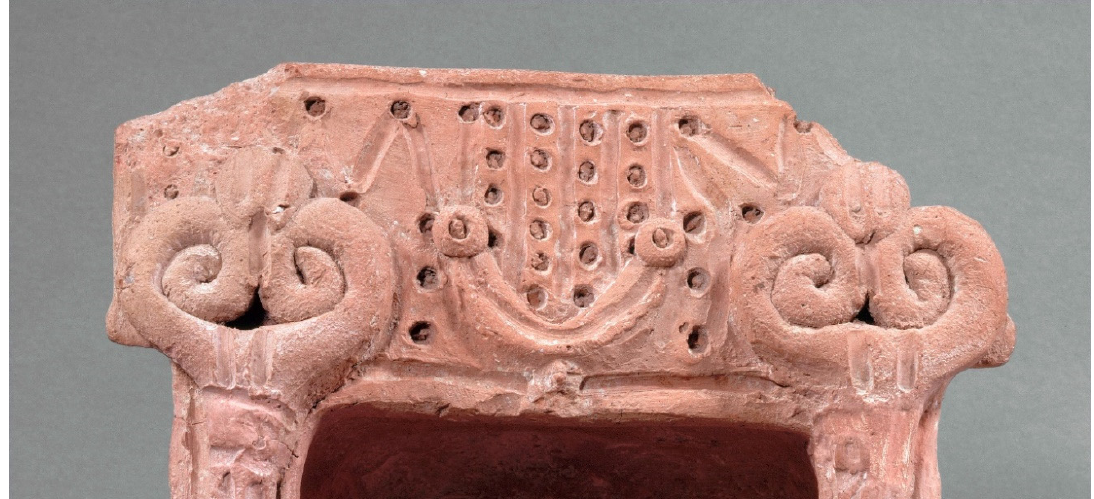
Figure 12. Close-up of the upper façade of the portable shrine from Tell el-Far‘ah North (© RMN–Grand Palais, Musée du Louvre, les frères Chuzeville).